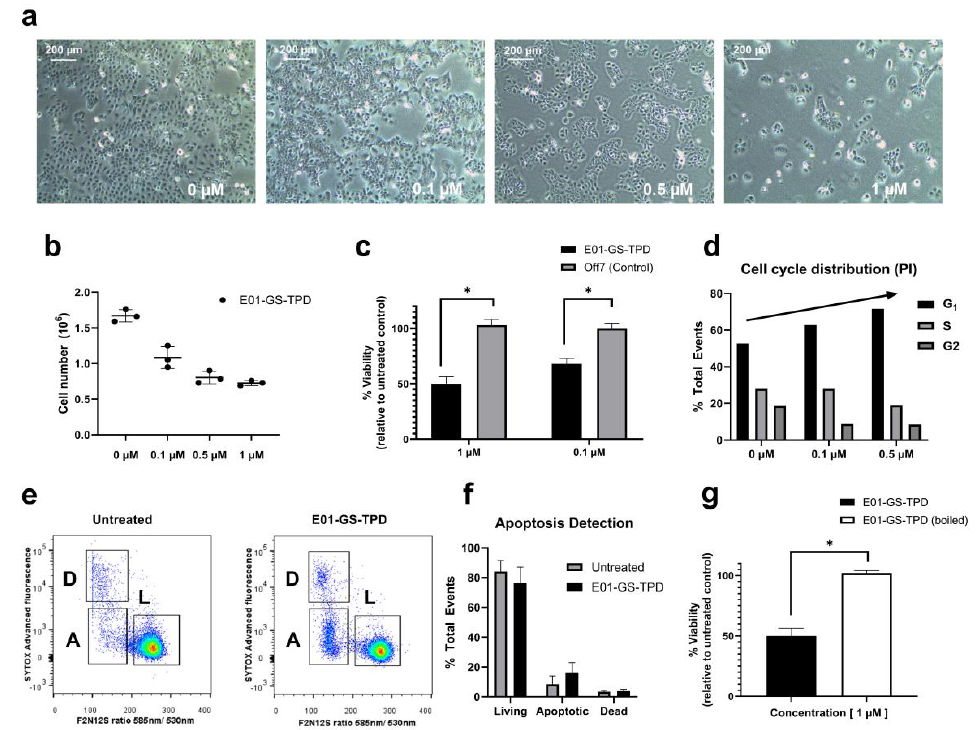
Figure 4. E01-GS-TPD inhibits EGFR / ADAM17-dependent A431 cell proliferation. A431 cells were treated with fusion protein E01-GS-TPD at increasing concentrations for a total of 48 h. ( a ) confluency and ( b) cell number were examined. ( c ) cell viability following treatment was determined by 3-(4,5-